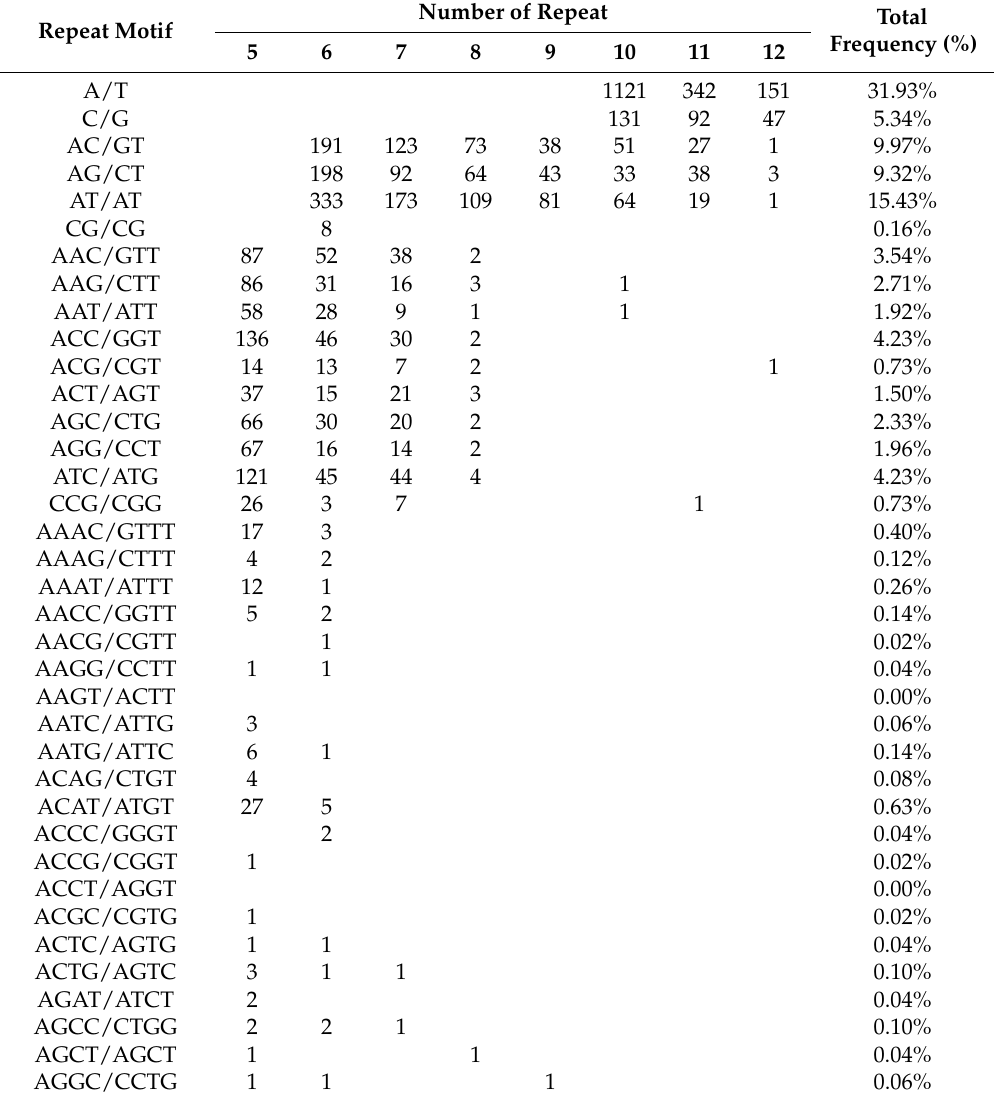
Table 3. Statistics of microsatellites of different motif types and repeat numbers in G.